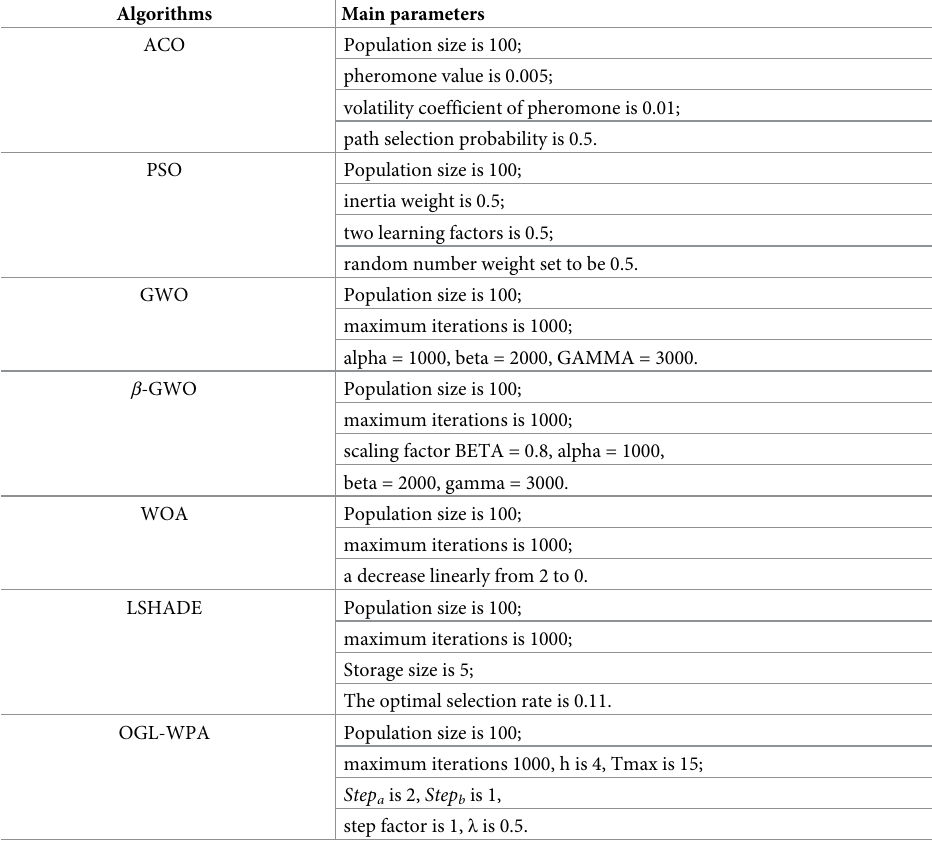
Table 1. Main parameters of the 7 algorithms.